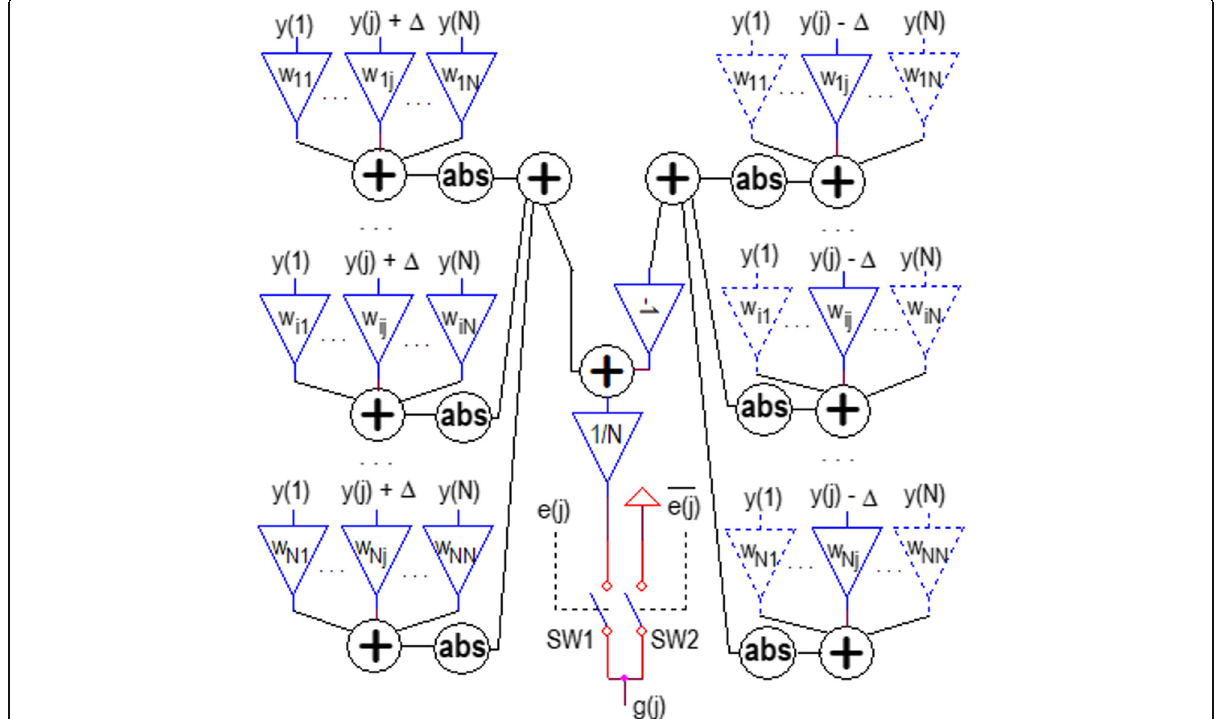
Fig. 6 Circuit for the calculation of gradient sample at position j ( g j